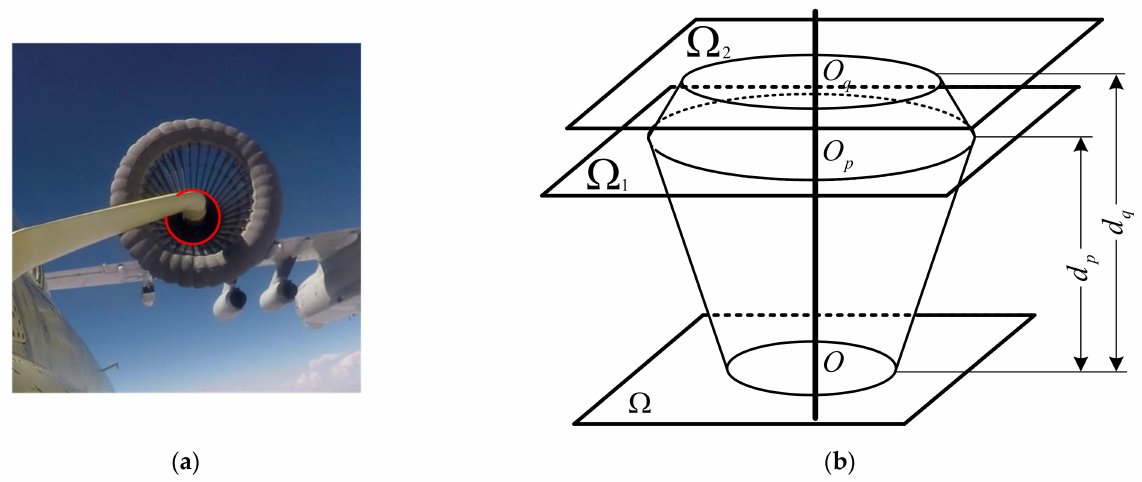
Figure 1. This is a figure of a drogue for aerial refueling. ( a ) The drogue during aerial refueling seen from the perspective of the receiver; ( b ) a side view of the drogue